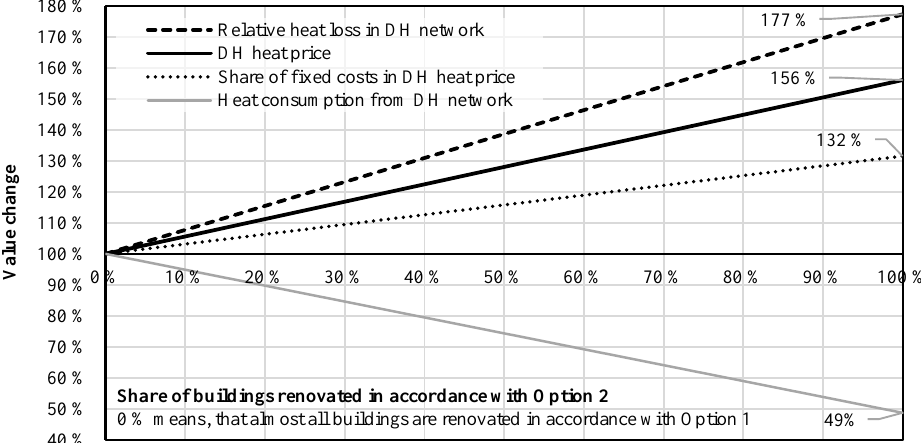
Fig. 3. Impact of an increased share of Option 2 building renovation solution implementation on relative heat loss, DH heat prices, the share of fixed costs of the DH heat price and heat